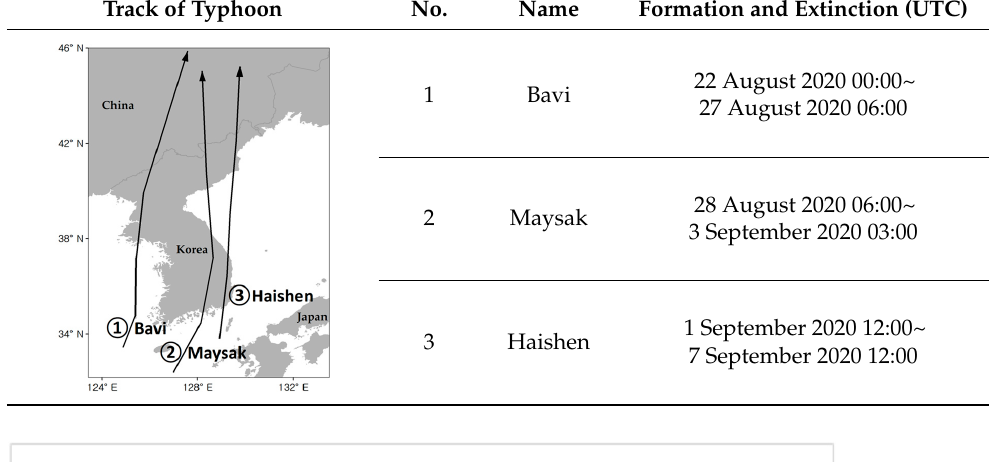
Table 9. Information on typhoons that affected the Korean Peninsula from August to September 2020. Track of Typhoon